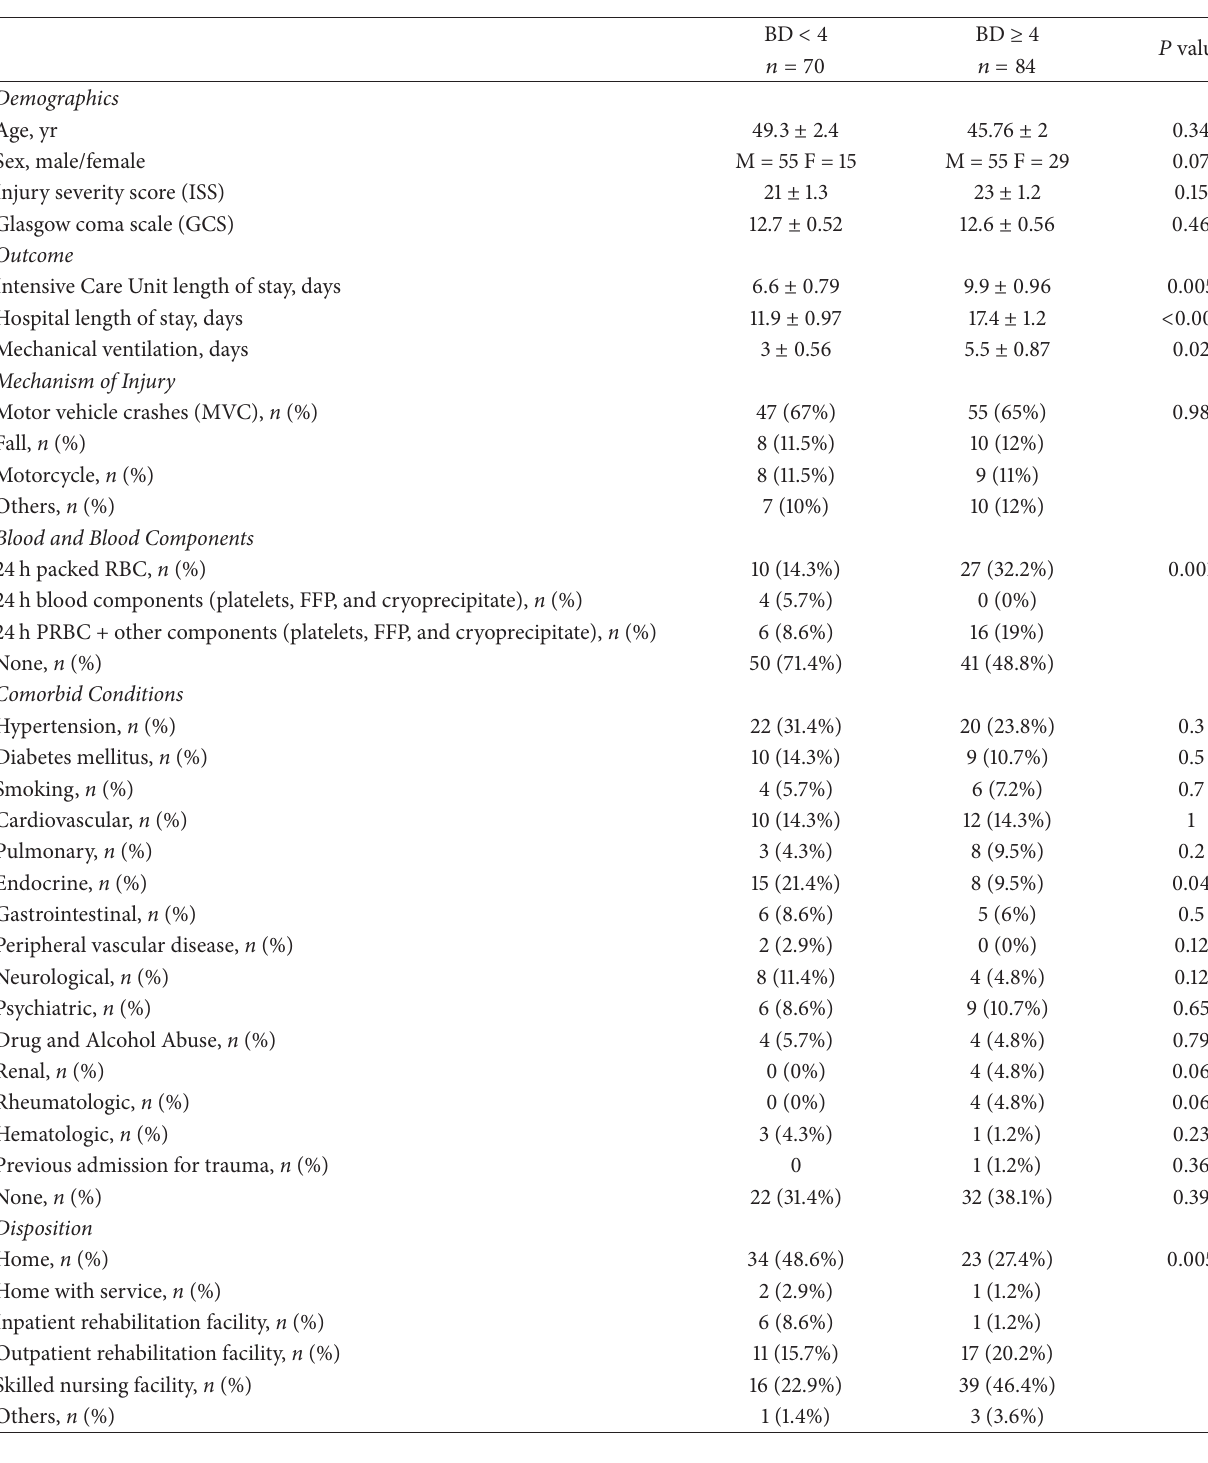
Table 1: Overall demographics, clinical outcomes, mechanism of injury, blood and blood components, comorbidities, and disposition of the BD < 4 ( 𝑛 = 70 ) and BD ≥ 4 ( 𝑛 = 84 ) subgroups. Values are expressed as mean ± SEM. Mann–Whitney U test, Fisher exact test, or Chi-square were used as appropriate with statistical significance set at 𝑃 < 0.05